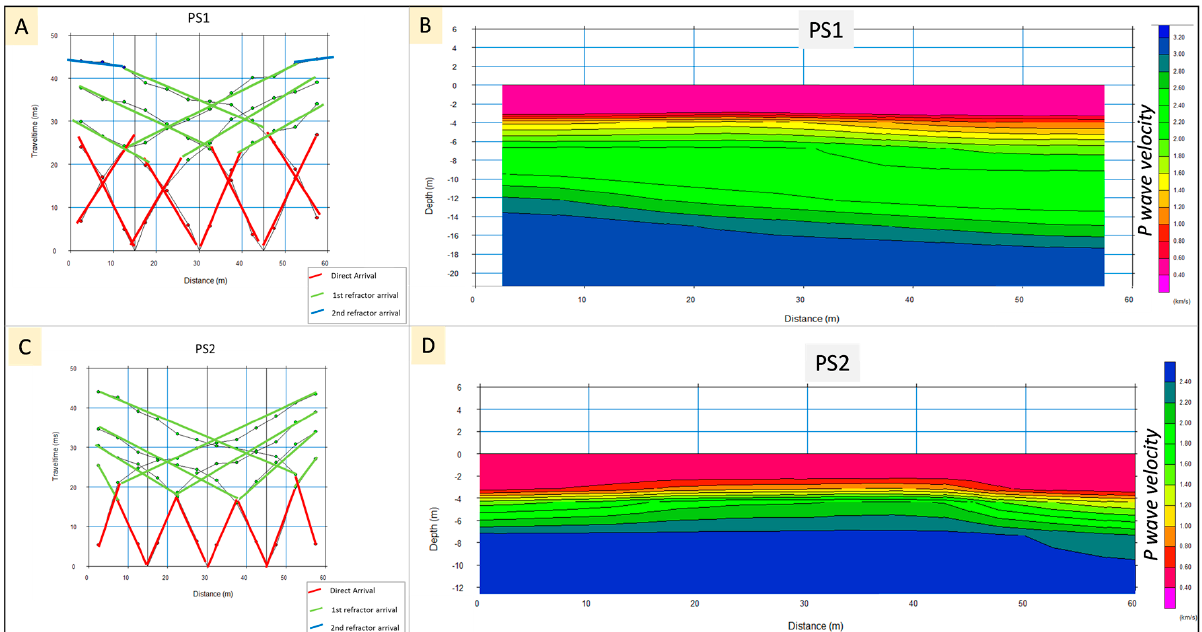
Figure 6. Graphs of travel time vs distance and refracted branches velocities for ( A ) Seismic profile PS1; ( C ) Seismic profile PS2. P-wave velocity model obtained by the tomographic inversion process for ( B ) Profile PS1; ( D ) Profile